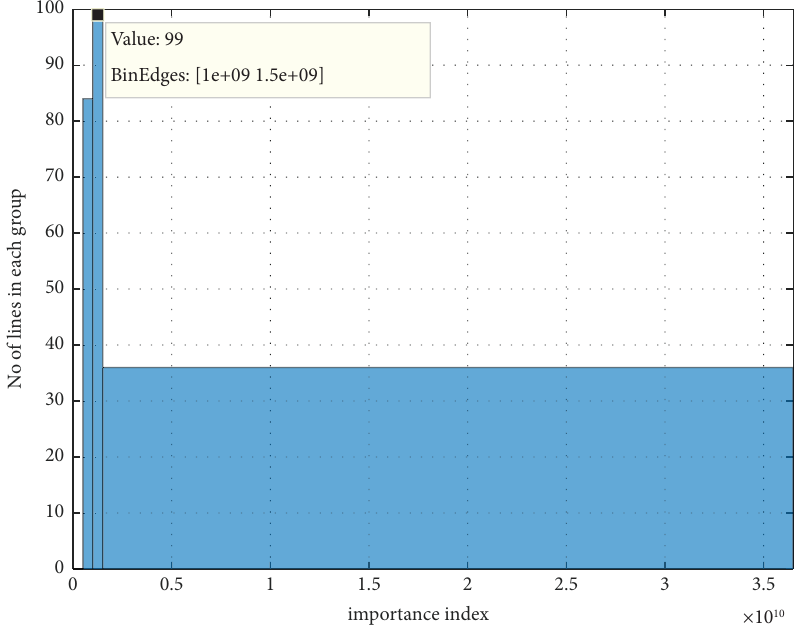
Figure 9: Histogram curve of lines importance index.